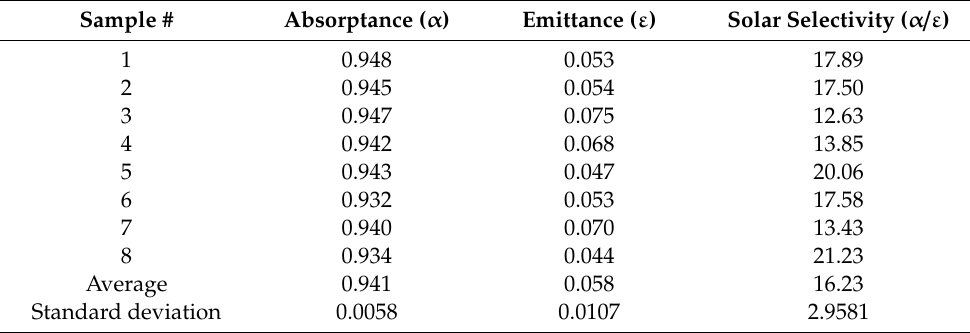
Table 3. The optical characteristics of SSC, which were deposited under the same process. Sample # Absorptance ( α